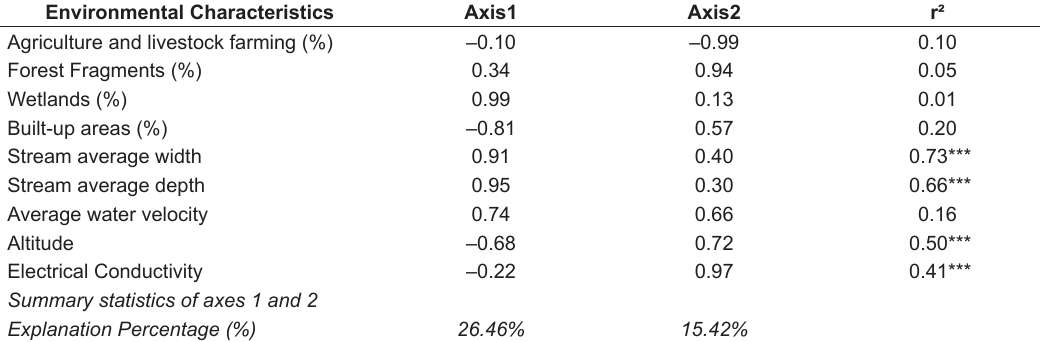
Figure 5. Regression tree of fish species richness in streams of the Ivinhema River basin, Upper Paraná River, from 2001 to 2013. Table 1. Results of the Canonical Correspondence Analysis (CCA) for fish communities of the Ivinhema River, Upper Paraná River. *= Significant at α = 0.05; *** = Significant at α =